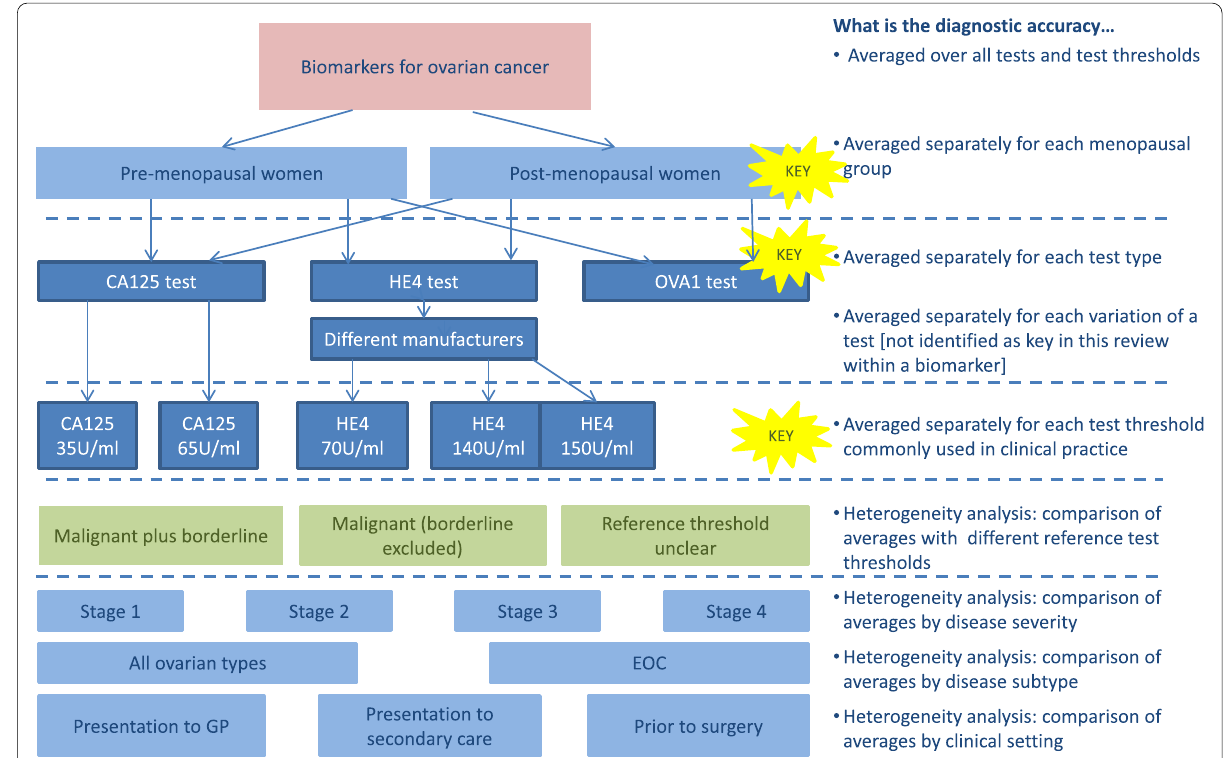
Fig. 2 Flowchart of planned analyses: Ovarian cancer serum biomarker review. Different components of variation leading to complexity in review of serum biomarkers in ovarian cancer. Coloured boxes indicate the TOMAS-R domain where complexity identified: pink boxes review topic; light blue boxes participant domain; dark blue boxes index test domain; light green boxes target condition domain. Dotted lines separate complexity and allow alignment to the diagnostic accuracy that the analysis would address. Each bullet point follows the question “What is the diagnostic accuracy...” so for example if test results are separated by the menopausal status of the women, the second bullet point is used so the analysis will answer the question “What is the diagnostic accuracy averaged separately for each menopausal group ?” Yellow stars indicate key complexities identified as requiring separate analyses for the review to have clinical